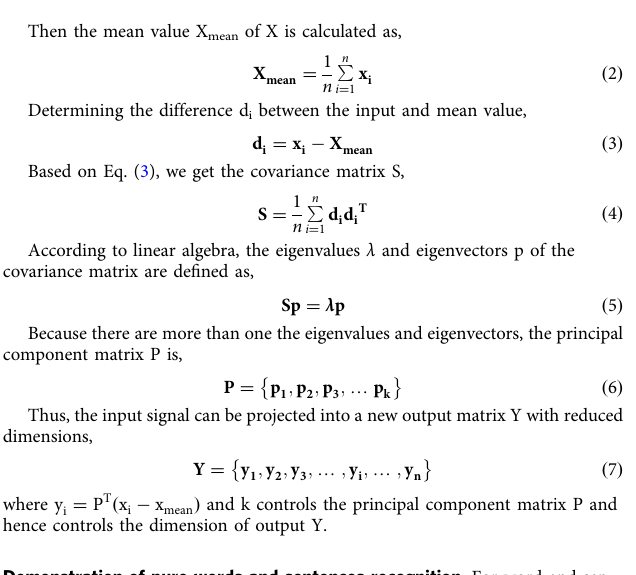
Fig. 5 The demonstration of communication between the speech impaired and the nonsigner. a Flow chart of the sign language recognition and communication system, which allows the signer to use sign language and nonsigner to types directly to engage in the interaction. The delivered sign language by the signer is recognized and translated into text and speech by AI block. Based on TCP/IP, the client (controlled by signer Lily) in VR interface receives the recognition results and transmits to the sever (operated by the nonsigner Mary). The nonsigner types on the chat box to respond to the signer. b (i – v) Communication/conversation process in VR interface between the speech-disordered user Lily and nonsigner Mary based on the sign language recognition and communication system. The red rectangle indicates the corresponding reaction of these two users. These photos are of one of the